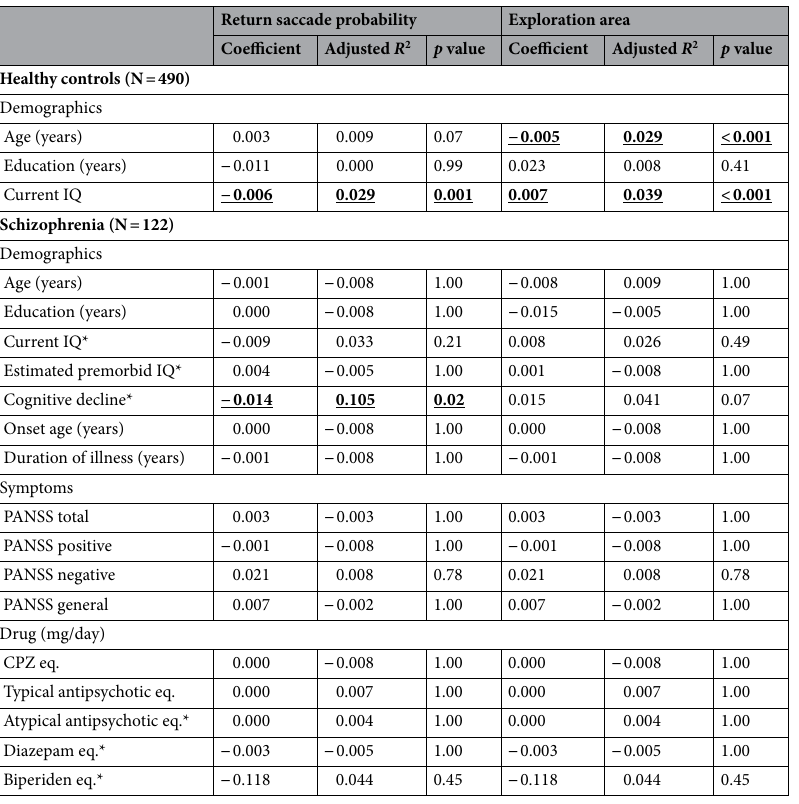
Table 2. Regression coefficients for return saccade probability and exploration area explained by the demographic and clinical characteristics of HCs and SZs. Bonferroni-corrected p values (raw p value × 3 for HCs, × 16 for SZs) and adjusted R 2 are shown. A negative adjusted R 2 is interpreted as zero variance explained. Bold underlined values highlight statistically significant contributions ( p < 0.05). *In SZs, N = 121 for current IQ, estimated premorbid IQ, cognitive decline, and atypical antipsychotic eq., N = 94 for diazepam eq., and N = 80 for biperiden eq. PANSS Positive and Negative Syndrome Scale, CPZ eq . chlorpromazine